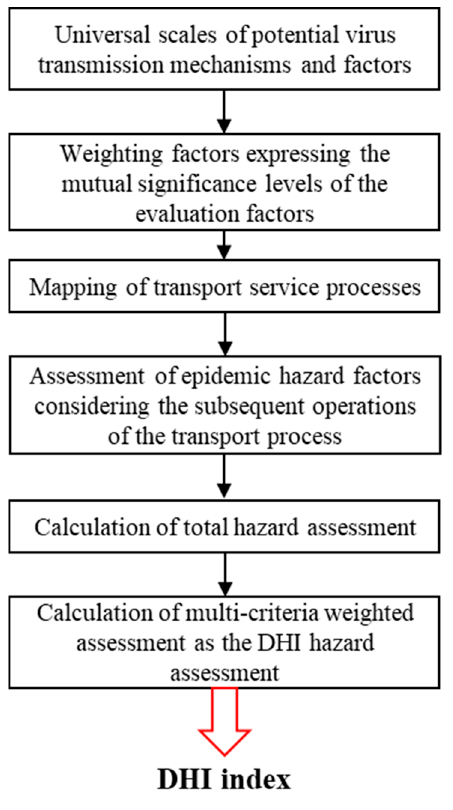
Figure 1. The process of implementing the DHI method and calculation of DHI index.